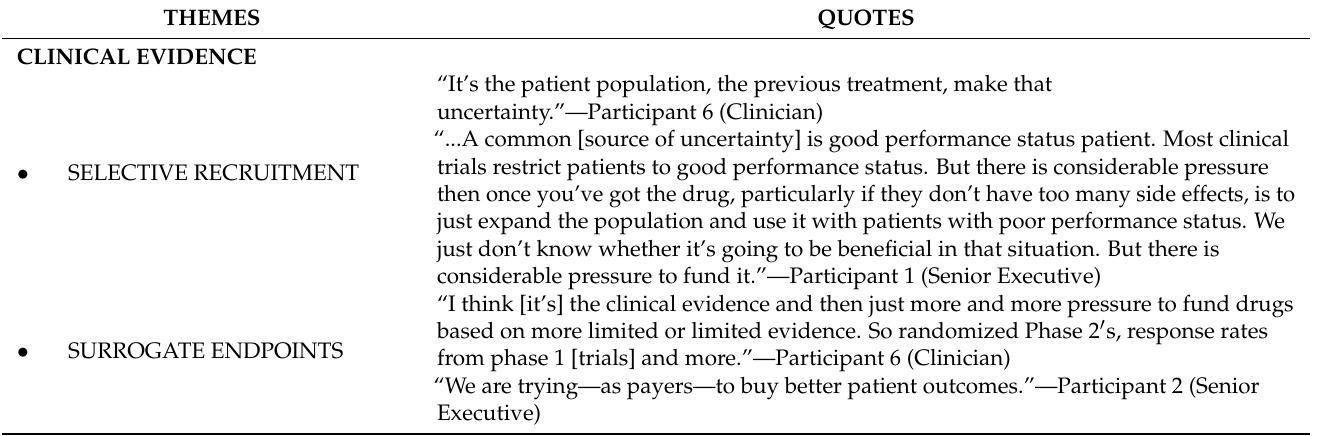
Table 1. Illustrative quotes for themes of uncertainty identified by Canadian decision